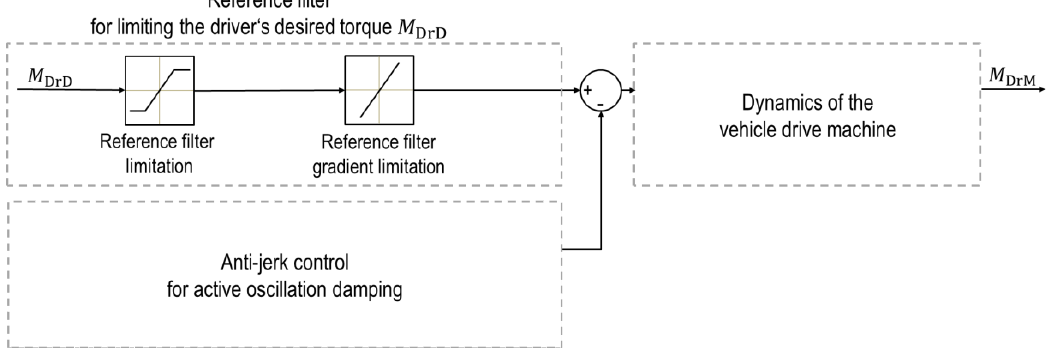
Figure 6. Drivability function with the reference filter and dynamics of the vehicle drive machine.